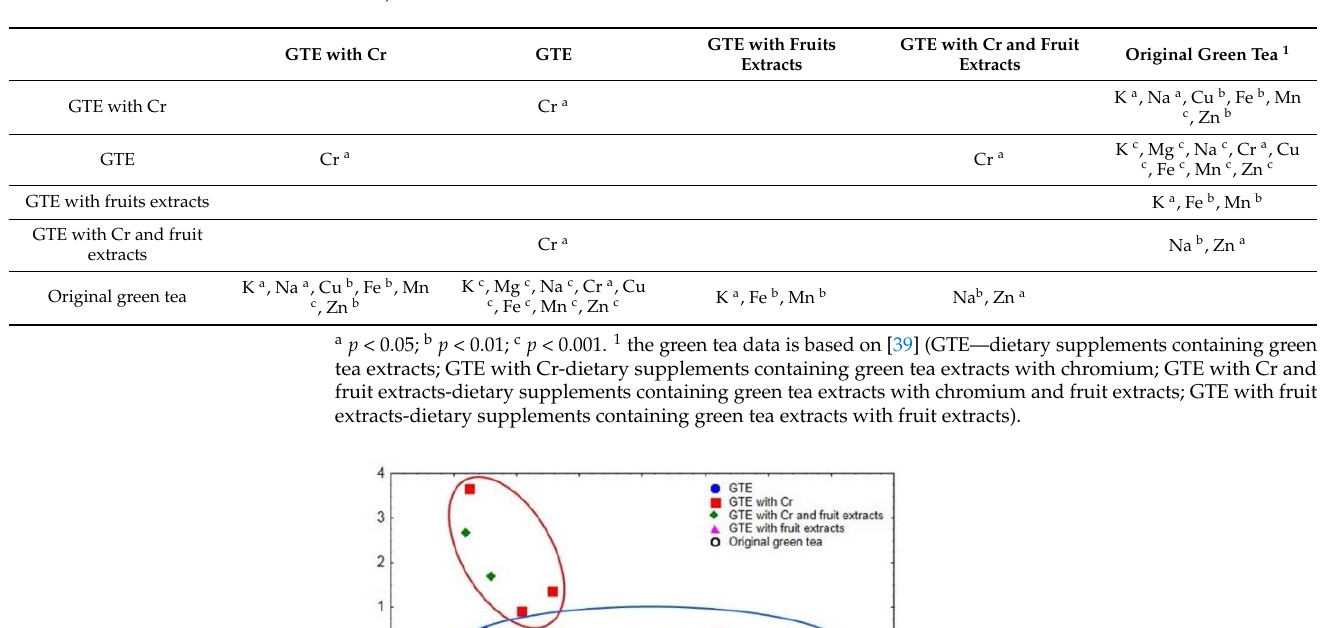
Table 5. Results of the Dunn’s test conducted for the analysed data matrix ( p < 0.05; p < 0.01; p < 0.001).